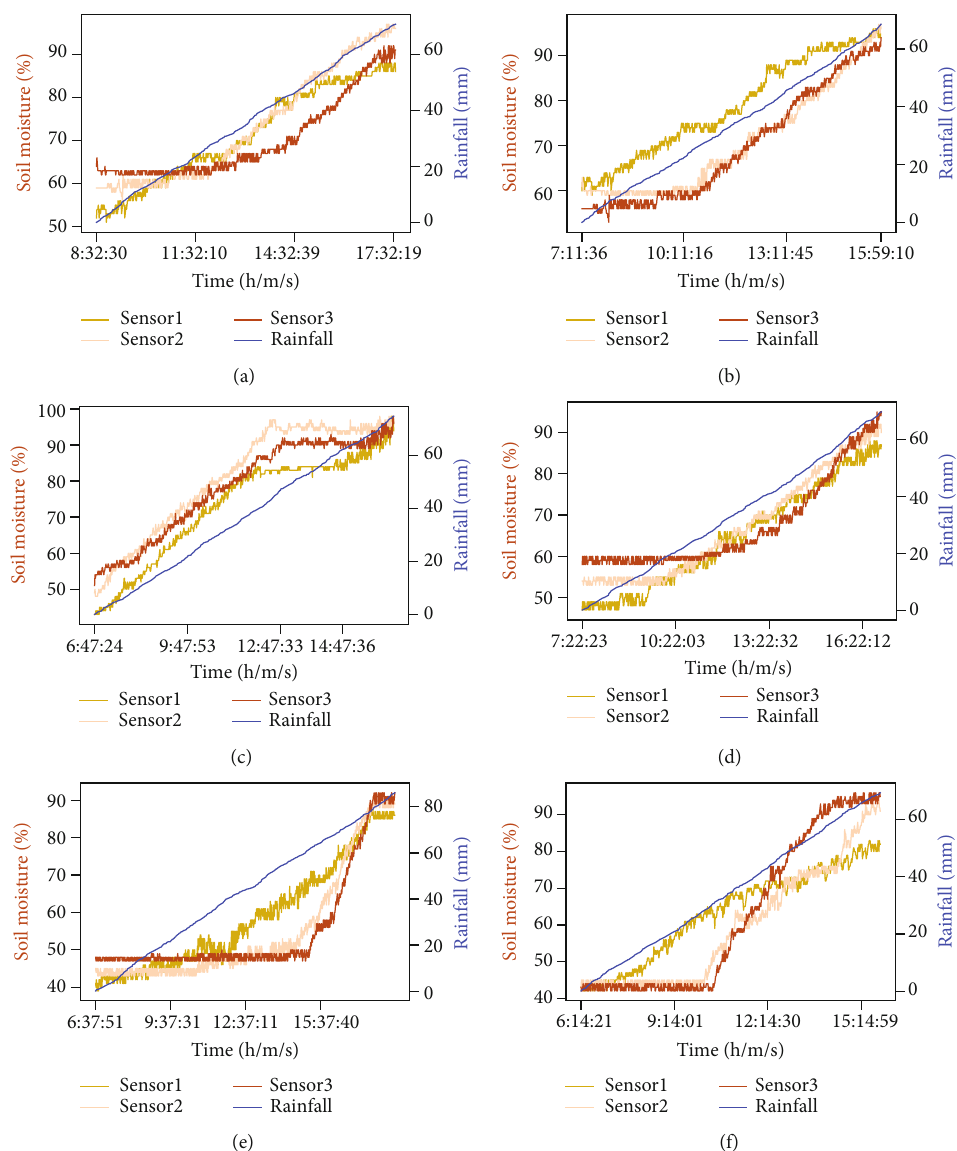
Figure 8: Variation of soil moisture content versus rainfall for three tests on site SC2 (a – c) and site SD3 (d –